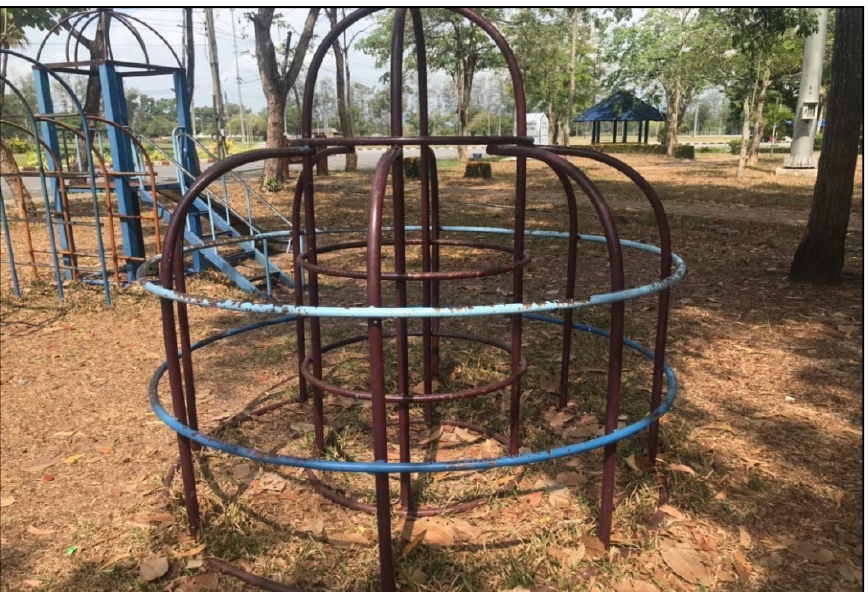
Figure 3. Jungle gym: The height from the floor was more than 1.8 m where a child might fall. There were no safety rails. The distance between the stairs was more than 32 cm. Color paint had peeled off of the playground equipment.